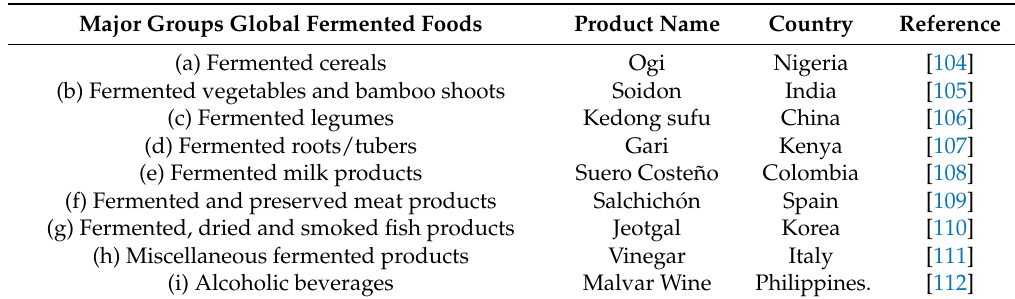
Table 7. Exemplificative cases of characterization of indigenous microorganisms selected from spontaneous fermentation in different